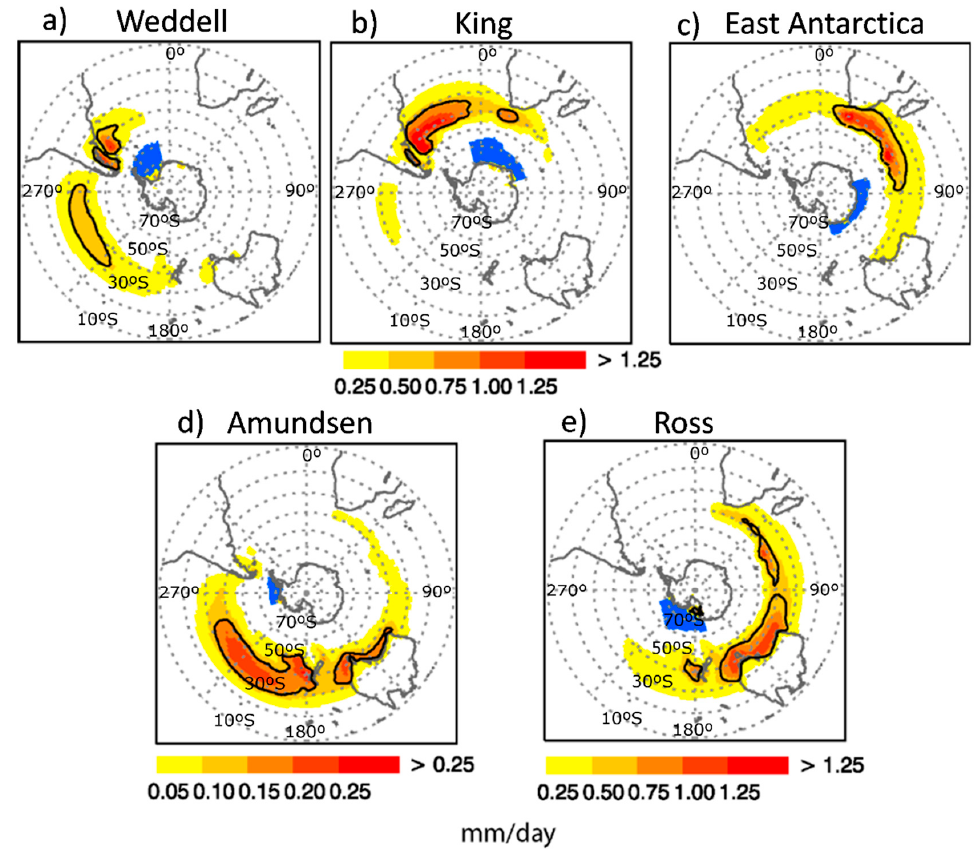
Figure 2. Annual climatology of 10 days integrated (E − P)i10 > 0 values (mm day − 1 ) for the period 1980–2015 determined from the backward tracking. Shaded (scales in the bottom) represents moisture sources and the black lines mark the threshold of the 75th percentiles of (E − P)i10 > 0 for each individual sea - being ( a ) Weddell, ( b ) King, ( c ) East Antarctica, ( d ) Amundsen and ( e ) Ross, blue indicates the target area on the forward analysis, i.e., the area with SIC values equal or greater than 0.1 for September. Note that the color scale for the Amundsen Sea di ff ers from that for the other